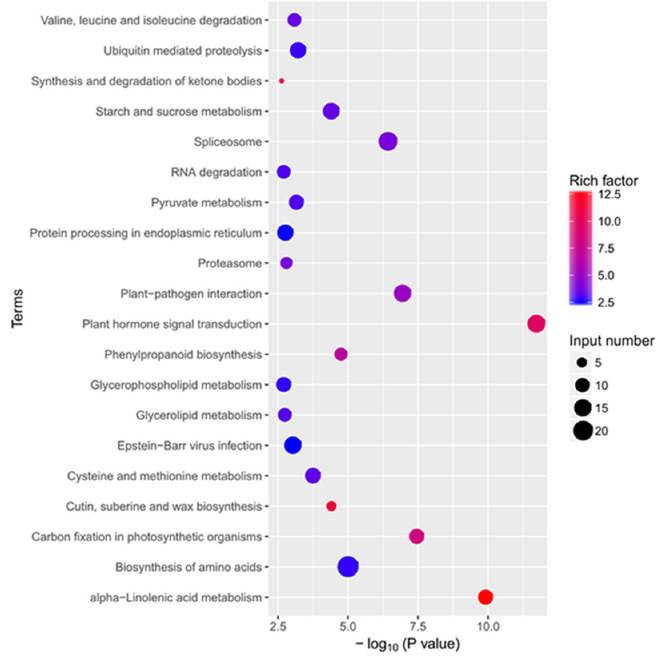
Figure 8. KEGG enrichment analysis of DEGs response to COS treatment.